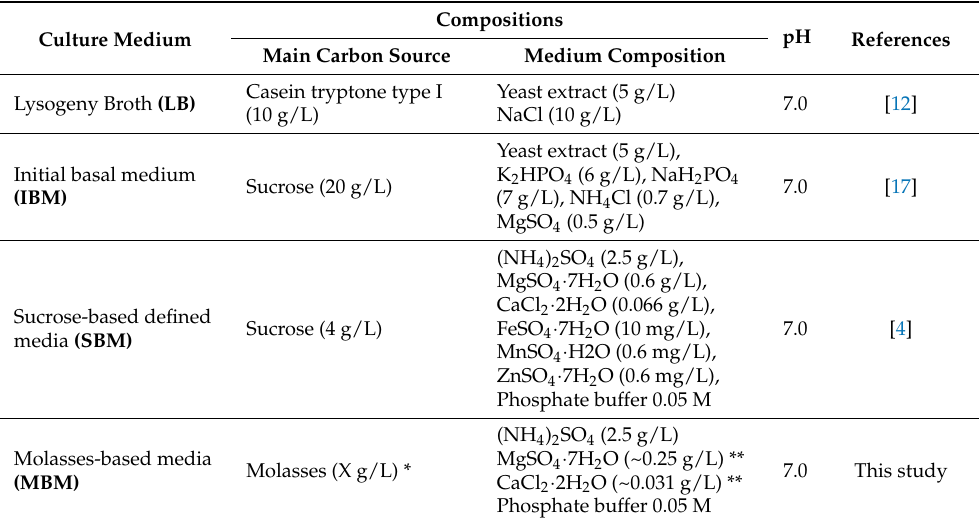
Table 1. Culture media used in this